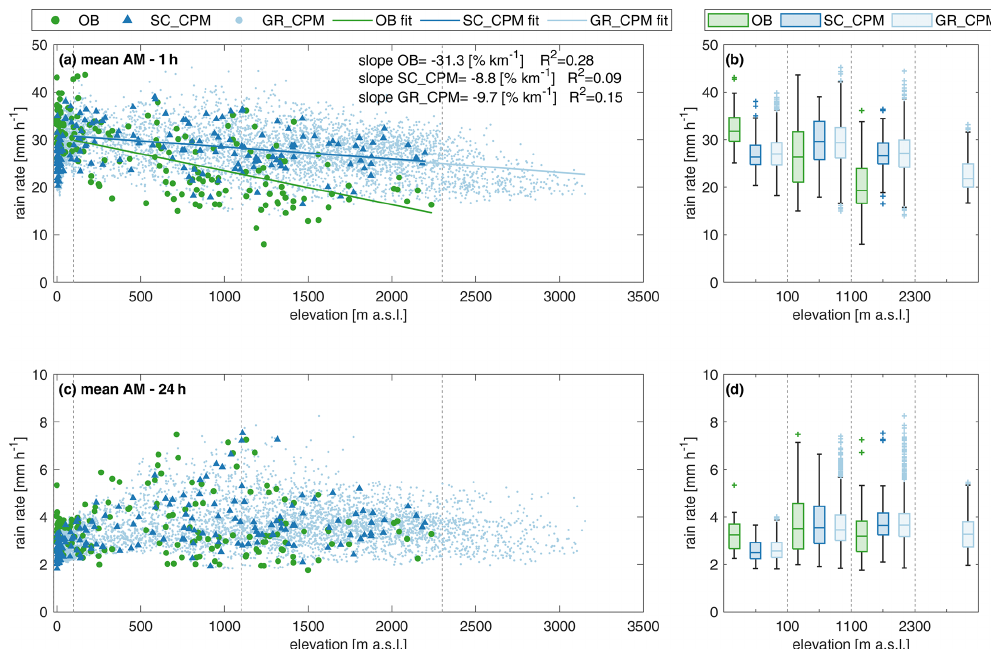
Figure 4. Orographic effect on 1 and 24h annual maxima for observation (OB), station-colocated CPM (SC_CPM), and all CPM grid points (GR_CPM). (a, c) Relationship of AM rain rate with elevation at 1 and 24h durations, respectively. In panel (a) , the linear regression lines shown as a solid line are expressed as a percent of the median value and are calculated for the stations above 100ma.s.l.; the coefficients of determination are indicated as R 2 . (b, d) Boxplots of AM rain rate at 1 and 24h durations, respectively, for the three rainfall datasets and four elevation groups. Note that the considered elevation data are one from each dataset (OB or CPM).